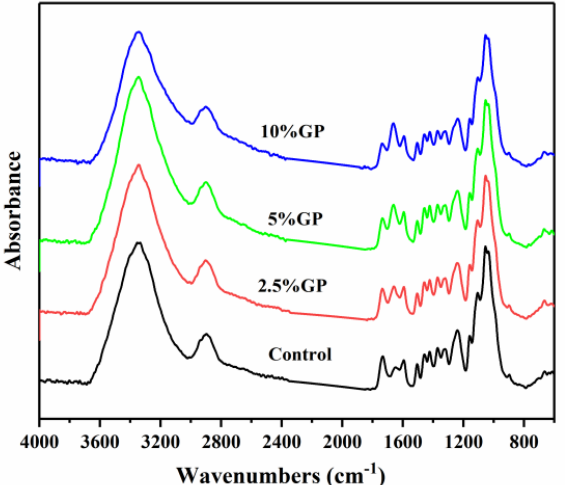
− IR spectra of wood, unmodified and modified by different GP Figure 2. FT−IR spectra of wood, unmodified and modified by different GP concentrations. Figure 2. FT